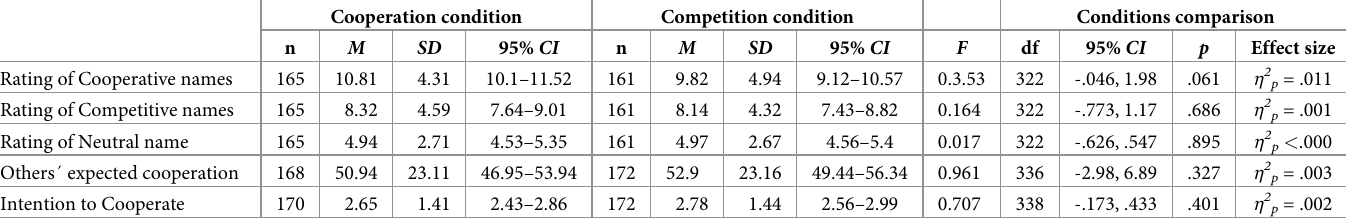
Table 1. Priming effects on name appropriateness rating, beliefs about other participants’ behavior, and own behavioral intentions in the Prisoner’s Dilemma game.